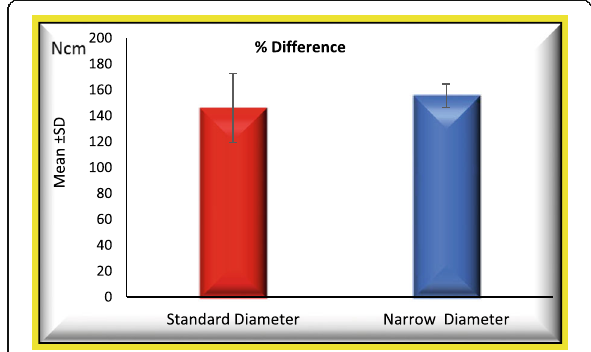
Fig. 8 Mean of percentage difference between initial and post load RTL 2 for GI and GII (regarding use of new abutment screw)